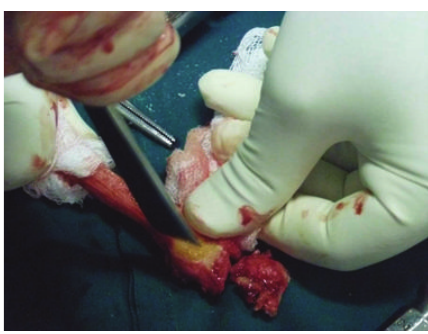
Figure 12: After distal ulna reconstruction.